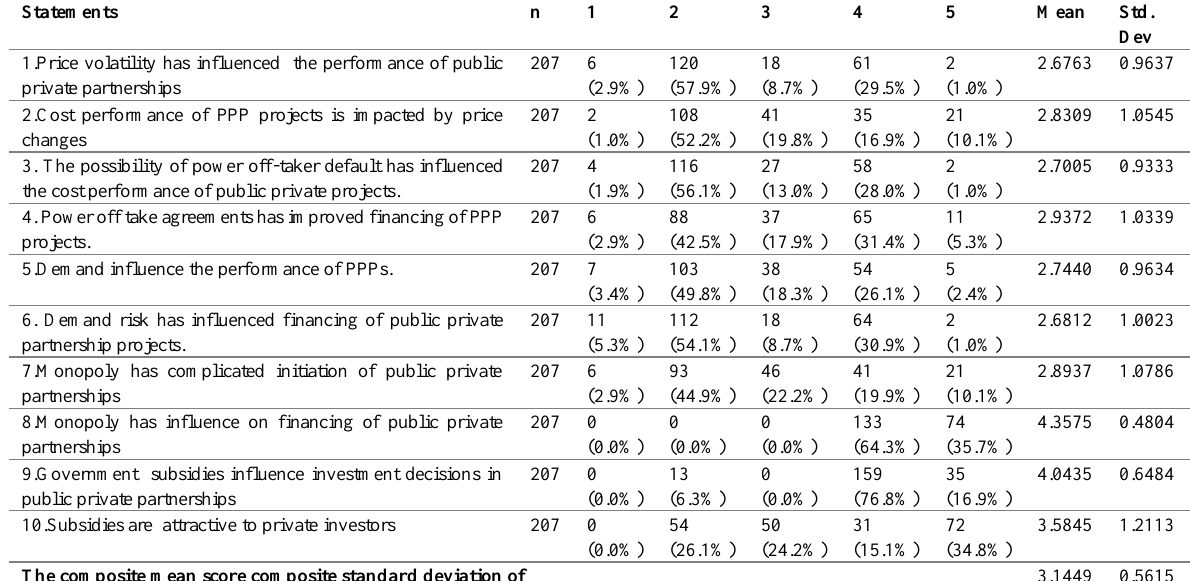
Table 3: Market risks and performance of public private partnerships renewable energy